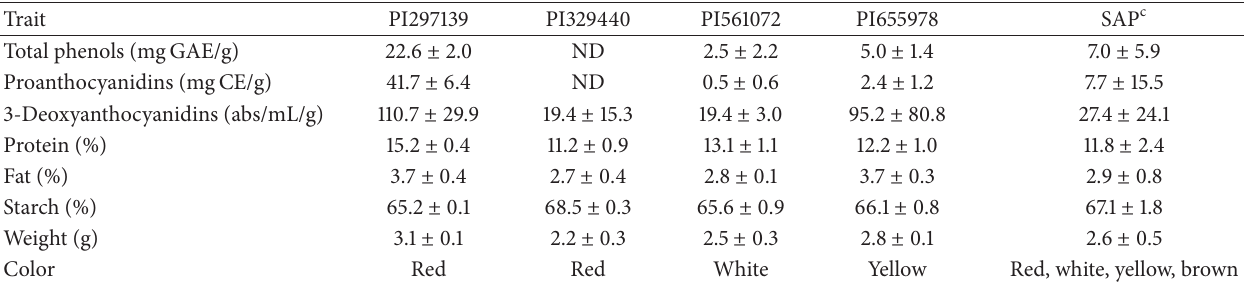
Table 1: Nutritional traits of sorghum accessions that reduce cytokine production a , b